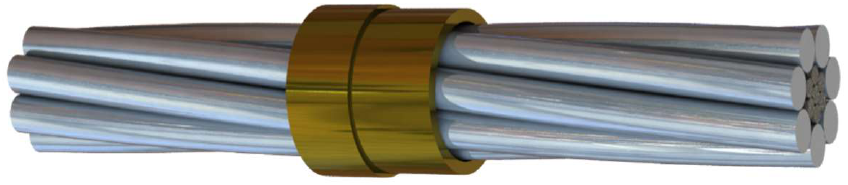
Figure 1. Coaxial driver coil, pickup coil, and transmission line.